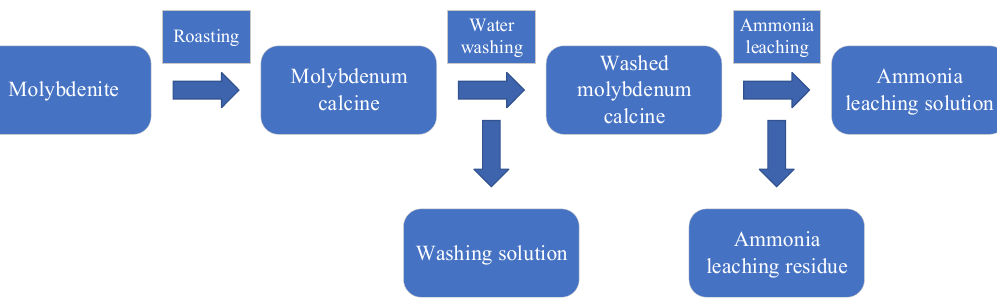
Figure 1. Ammonium molybdate production process.